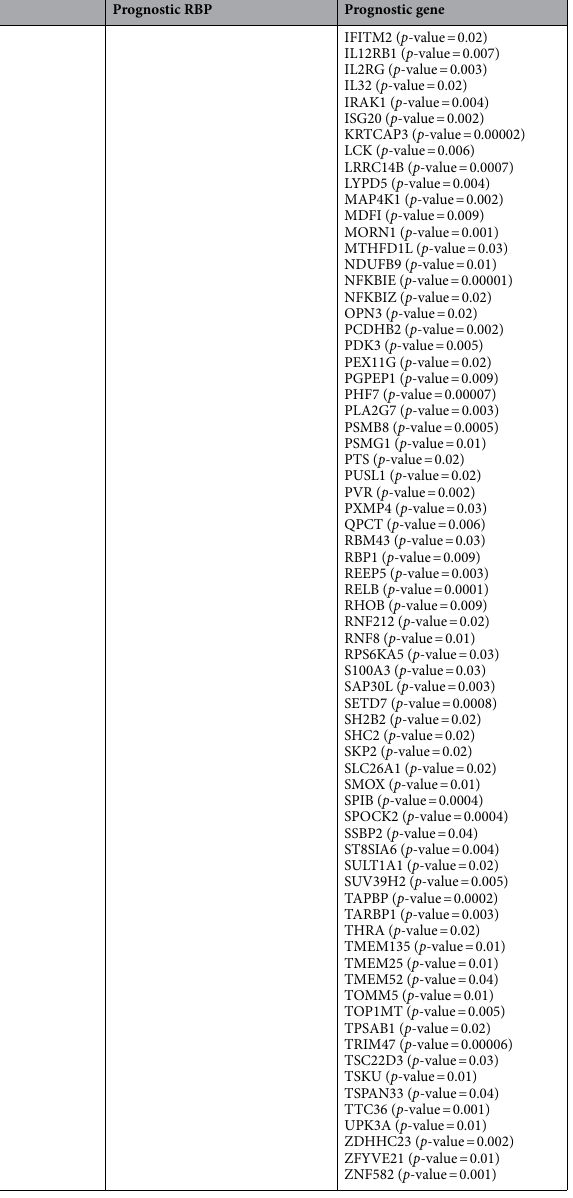
Table 4. List of potential prognostic subtype specific RBPs/genes as obtained from The Human Protein Atlas. P -value is indicated as obtained from the log-rank